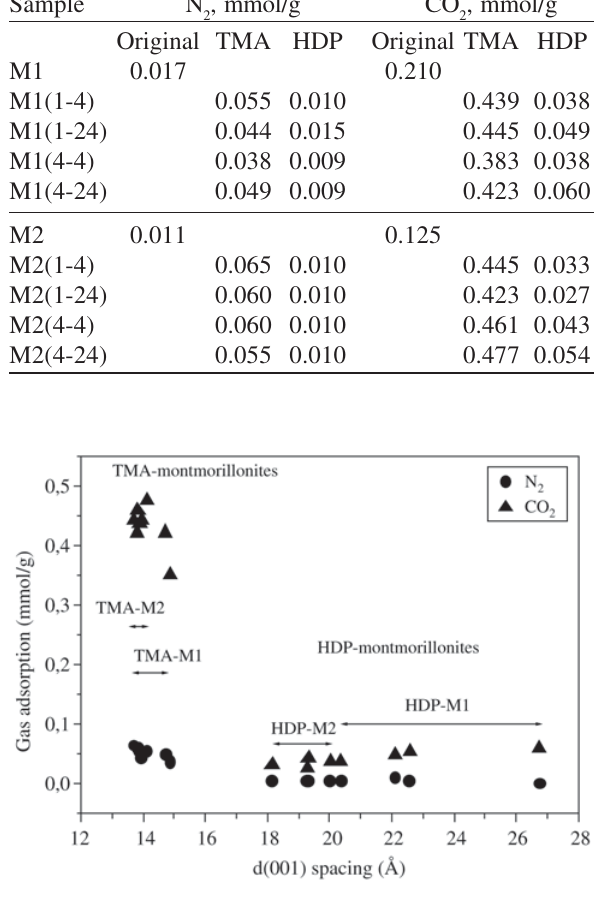
Figure 4. Gas adsorption vs. d(001) spacing of the organo- montmorillonites.